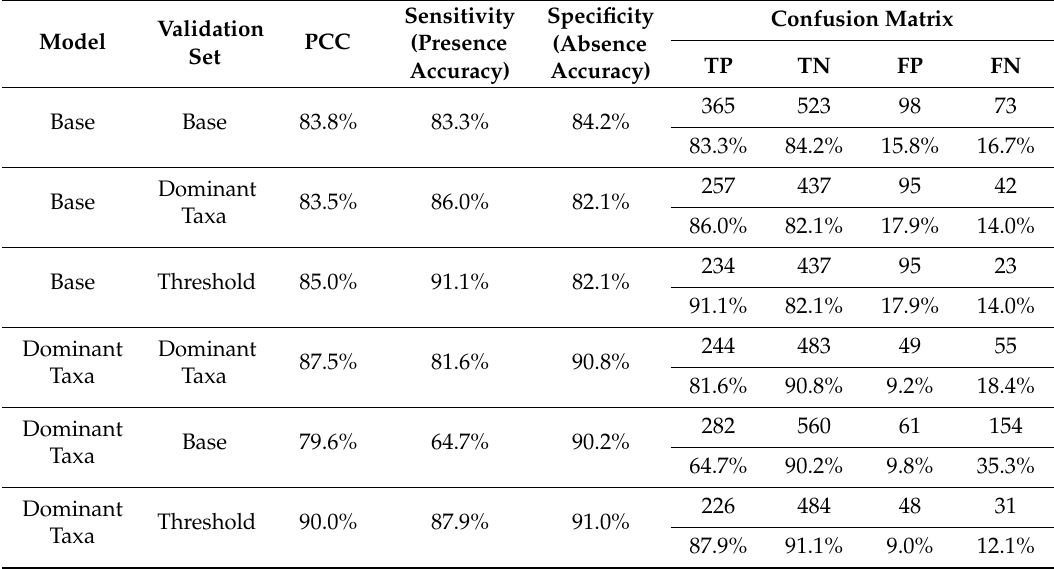
Table A2. Model evaluation metrics comparing overall and class accuracy between all models, with associated confusion